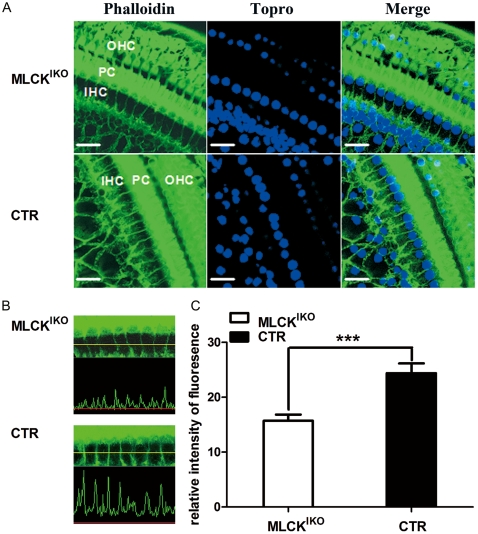
The actin cytoskeleton in the basilar epithelium of the organ of Corti.(A) In the cochleae of MLCKIKO mice, staining with phalloidin reveals decreased F-actin formation in the cytoplasm and cell membrane of IHCs, whereas its expression in pillar cells (PCs) and OHCs remains strong in comparison with that of CTR mice. The nuclei were stained (blue) with Topro. Scale bars: 20 µm. (B) Representative waveforms of F-actin fluorescence signals in CTR and MLCKIKO inner hair cells, captured by a LOYMUPS FLUOVIEW Ver.1.7.a Viewer. (C) Quantification of the relative intensity of the F-actin fluorescence signals in CTR (solid symbol, n = 10) and MLCKIKO inner hair cells (open symbol, n = 13). The bars represent the means ± S.E., *Significant difference compared with CTR. ***P<0.001.